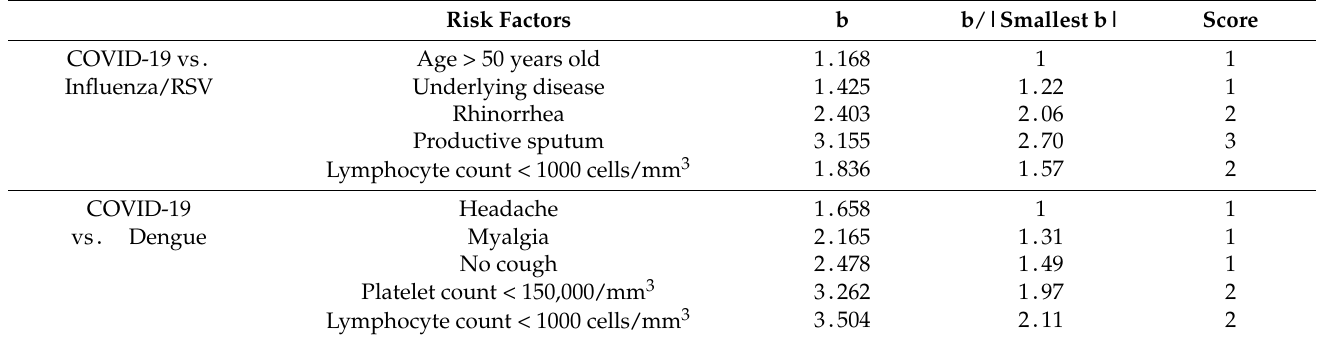
Table 6. Development of score to distinguish COVID-19 and influenza/RSV or dengue. Risk Factors